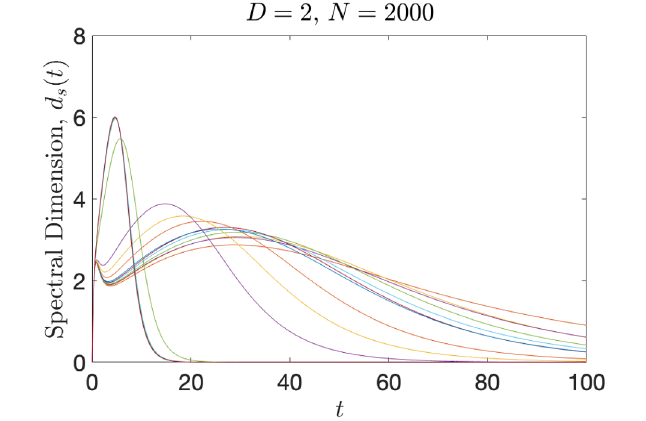
Figure 5 . The spectral function d s ( t ) of the 2D ground state graphs as a function of the coupling constant g ~ . The phase transition is clearly identifiable in a change of behaviour as the coupling constant is lowered. The violet curve corresponds to the case of an average of three squares per vertex discussed